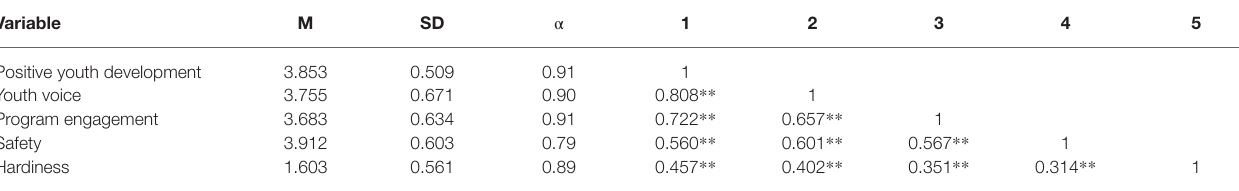
TABLE 1 | Descriptive statistics and bivariate correlations. Variable M Positive youth development